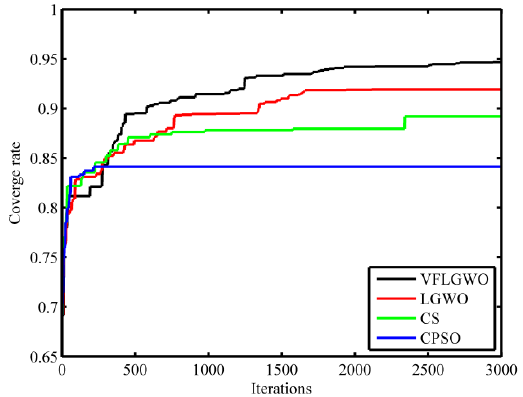
Figure 6. Coverage rate evolution curves of the four algorithms.